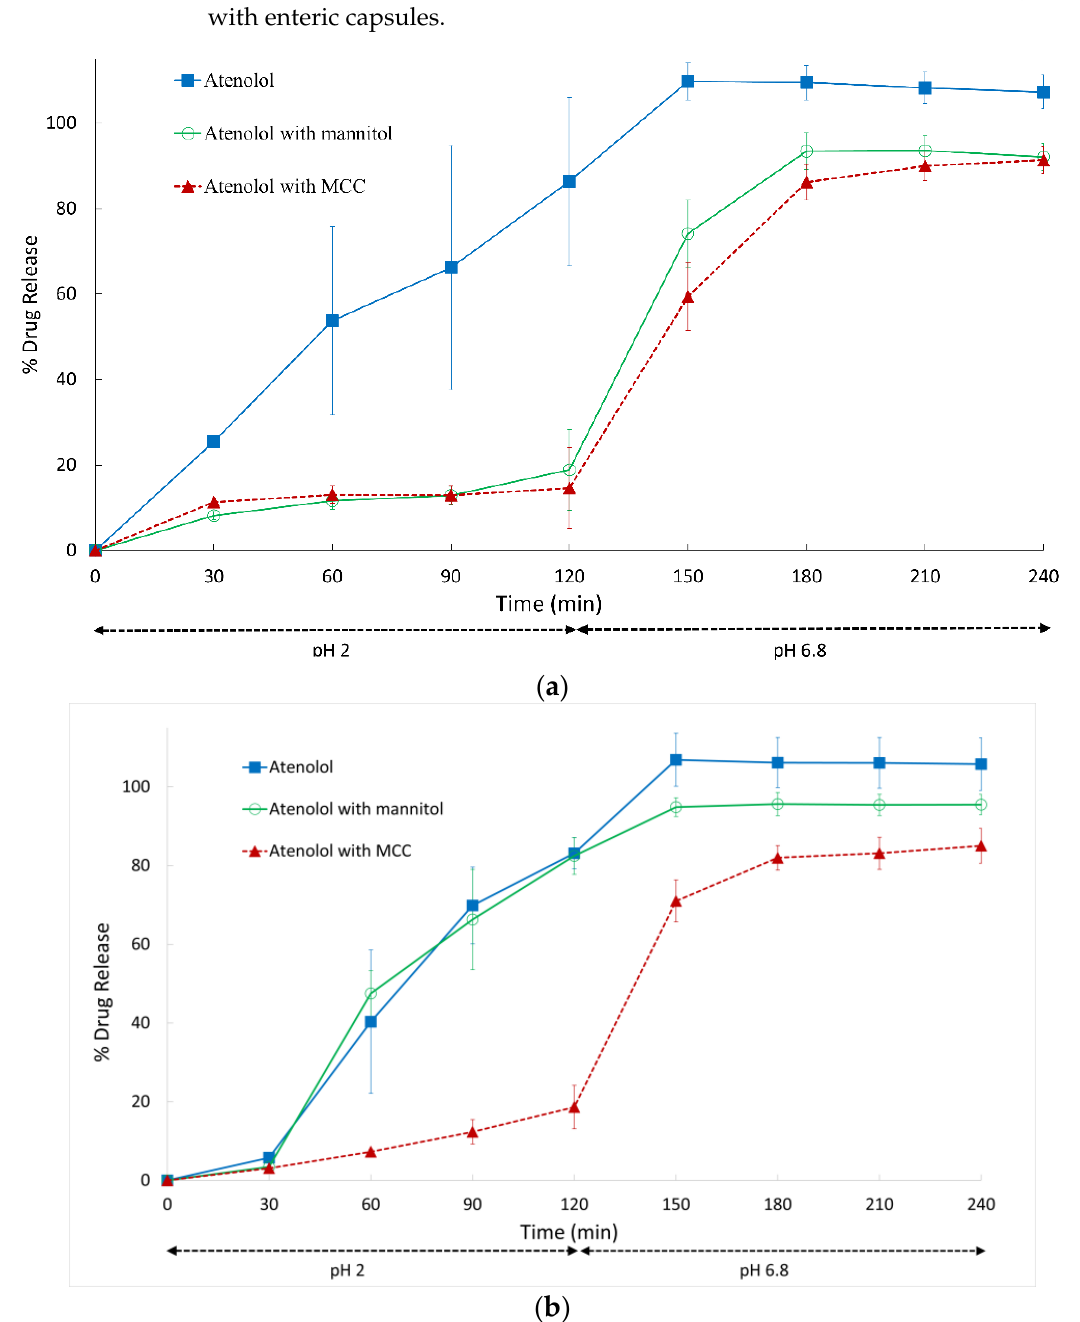
Figure 4. Dissolution profiles of Vcaps ® Enteric capsules filled with atenolol only or atenolol with diluent: ( a ) 20 mg atenolol or 20 mg atenolol with 280 mg diluent; ( b ) 100 mg atenolol or 100 mg with 200 mg diluent. Data shown as drug release mean % ± SD.